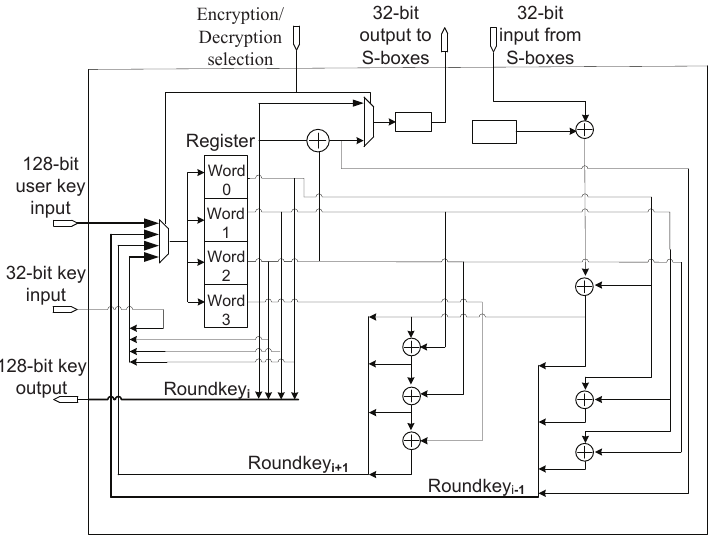
Figure 6. Main part of original key unit (for 128-bit AES